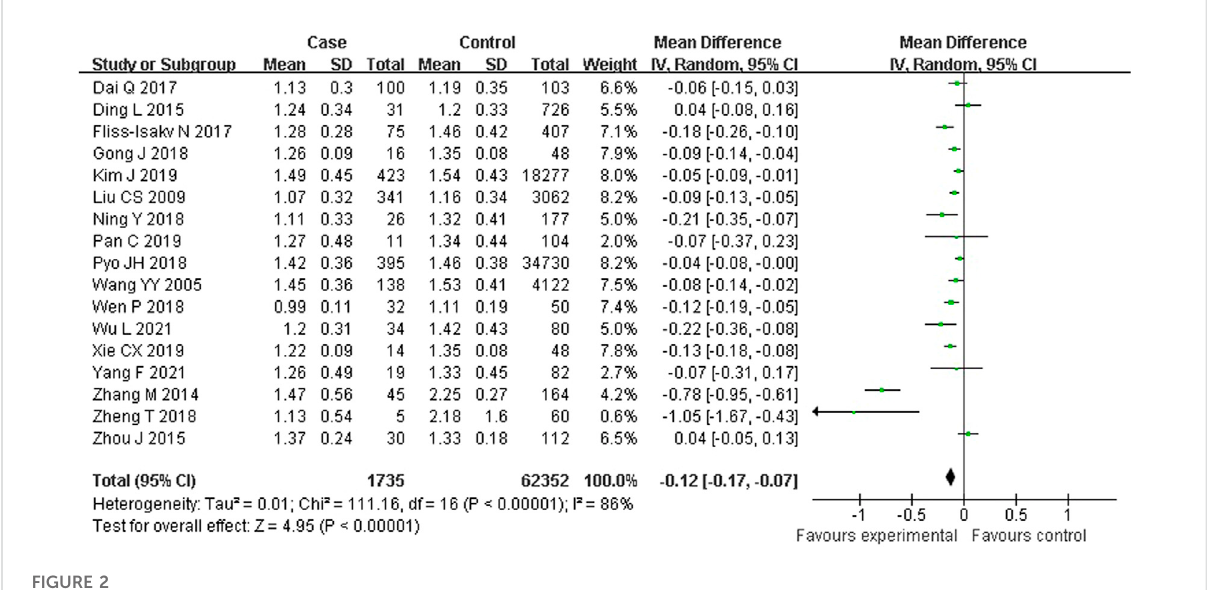
FIGURE 2 Forest plot of meta-analysis for association of serum HDL-C and colorectal serrated